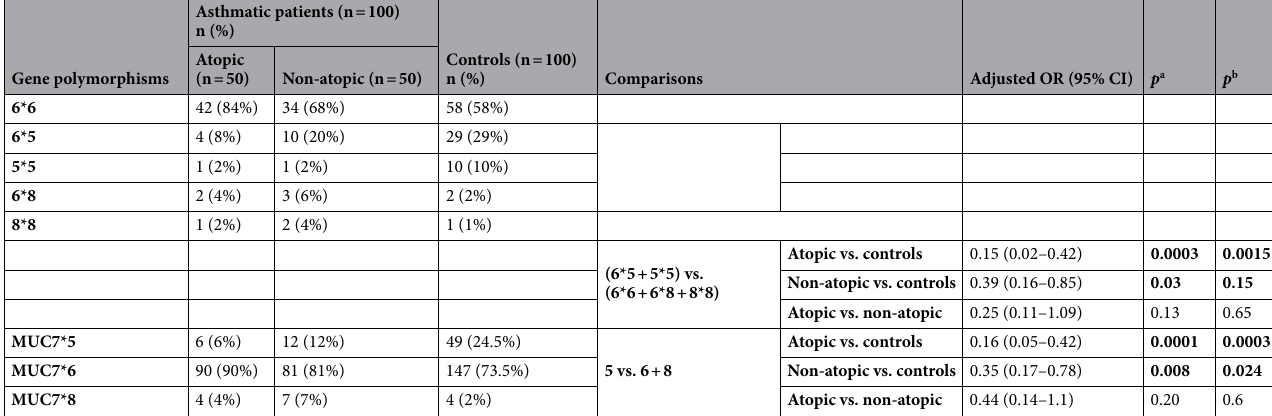
Asthmatic patients (n = 100) n